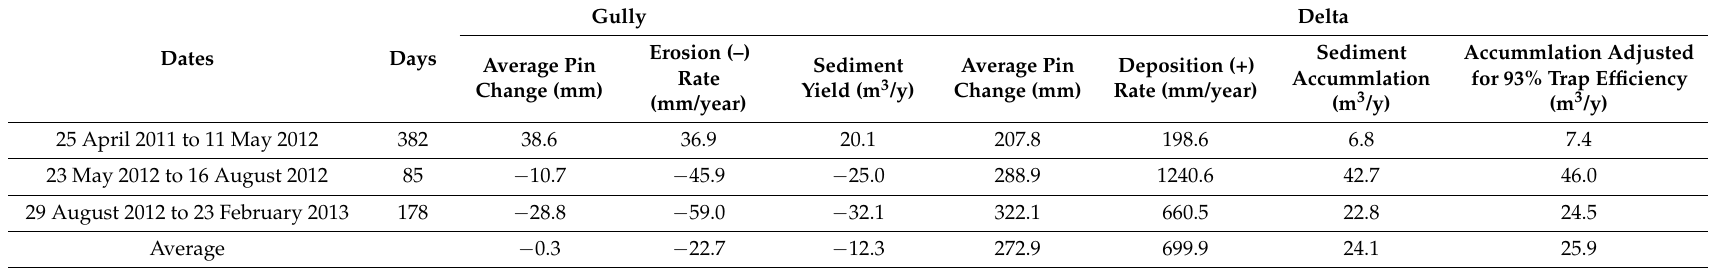
Table 2. Erosion pin change in length for delta pins (n = 12) and gully pins (n = 13). Positive values denote deposition and negative values denote